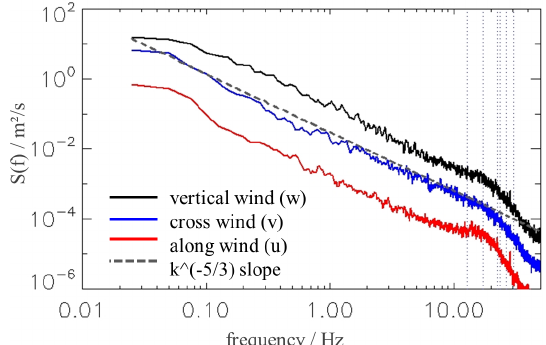
Figure 11. Power spectra of the three wind components in the air- craft coordinate system. The results of the vertical wind component ( w ) and the along-wind component ( u ) are shifted by 1 decade up- wards and downwards relative to the cross wind ( v ), respectively. The blue dotted lines on the right-hand side correspond to the res- onance frequencies of the METPOD and the aircraft as measured during a ground vibration test. For the spectral analysis, the data were detrended and the spectra bin-averaged with